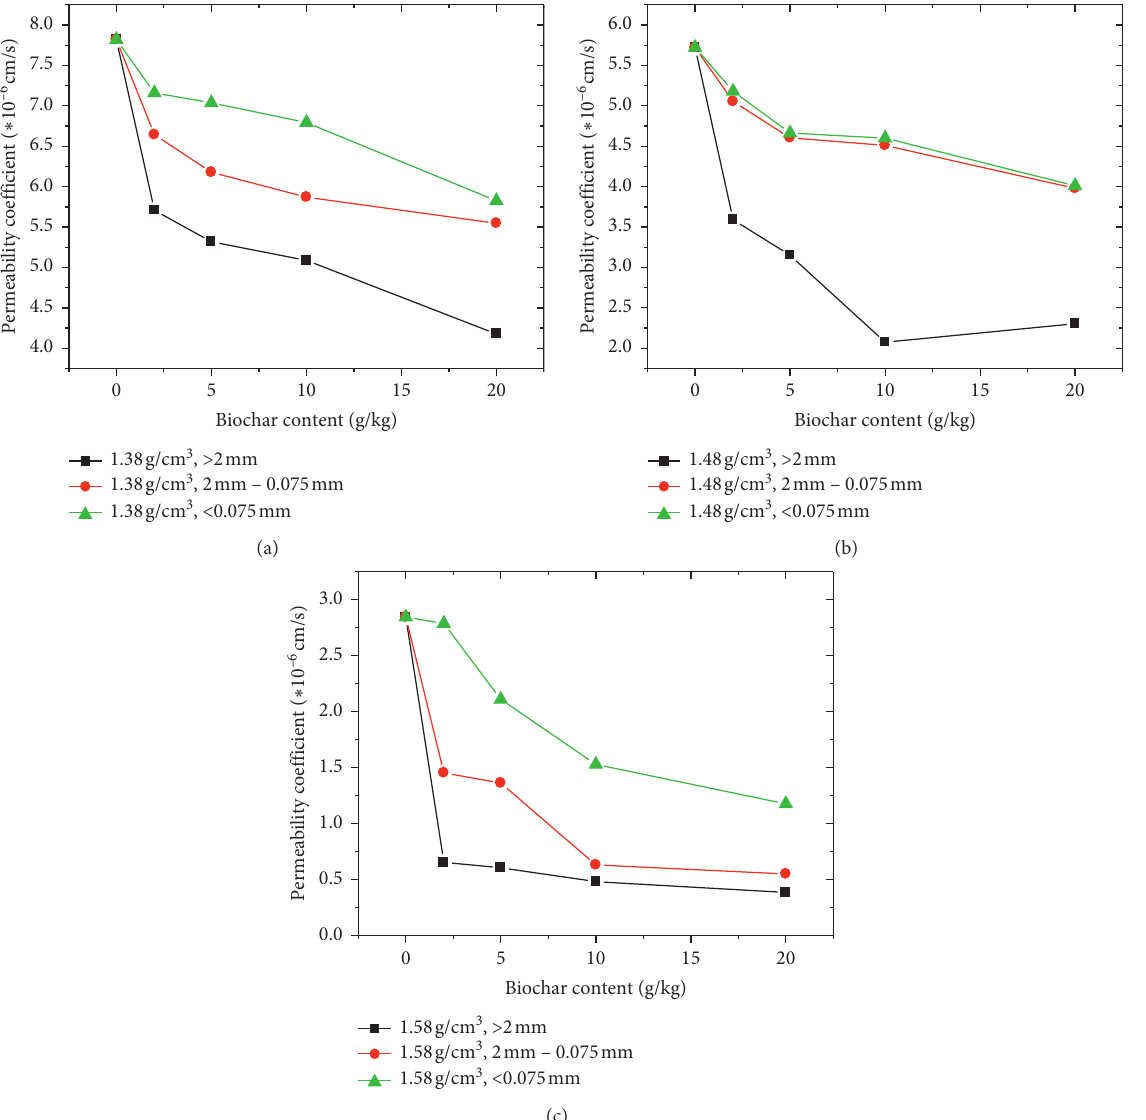
Figure 4: The variation of soil permeability coefficient (a) for ρ � 1.38g/cm 3 , (b) for ρ � 1.48g/cm 3 , and (c) for ρ � 1.58 g/cm 3